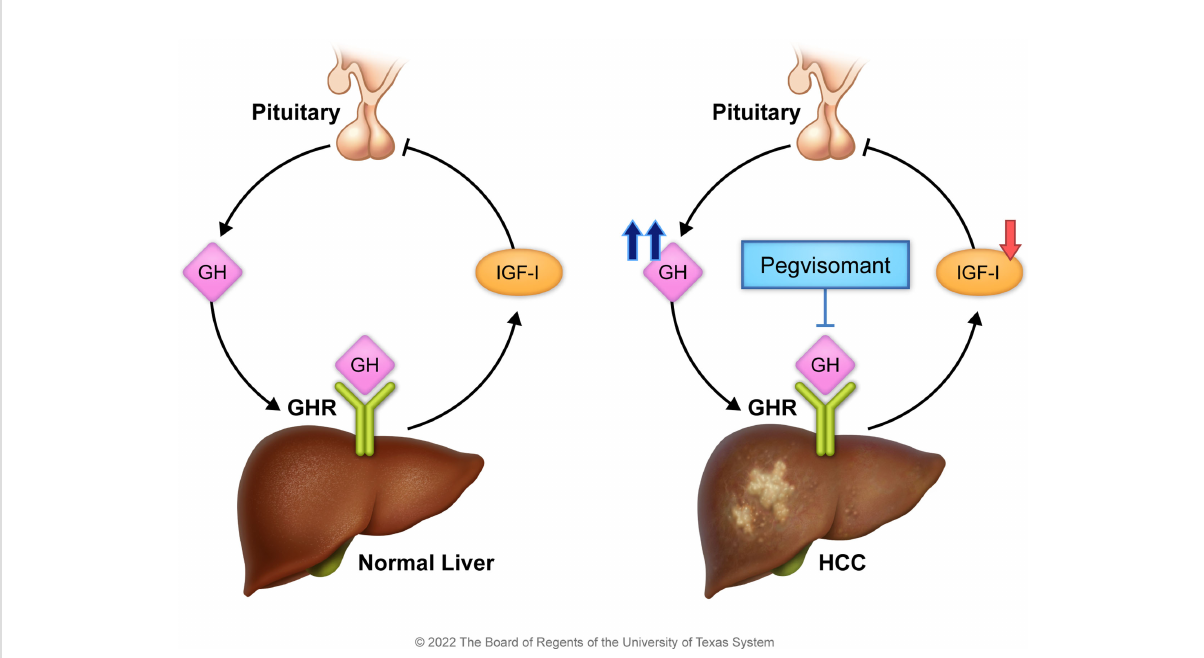
FIGURE 1 Working hypothesis and proposed model. Under the physiologic conditions (left panel), the pituitary secretes GH that activates hepatic GHR to stimulate IGF-I release. In turn, IGF-I suppresses the release of GH from the pituitary. In HCC (right panel), hepatic secretion of IGF-I is reduced because of liver insult, and its negative feedback effect on GH production is diminished. The marked production of GH by the pituitary promotes HCC survival. Hence, antagonism of GH/GHR binding by pegvisomant, a speci fi c blocker of GH/GHR signaling, suppresses